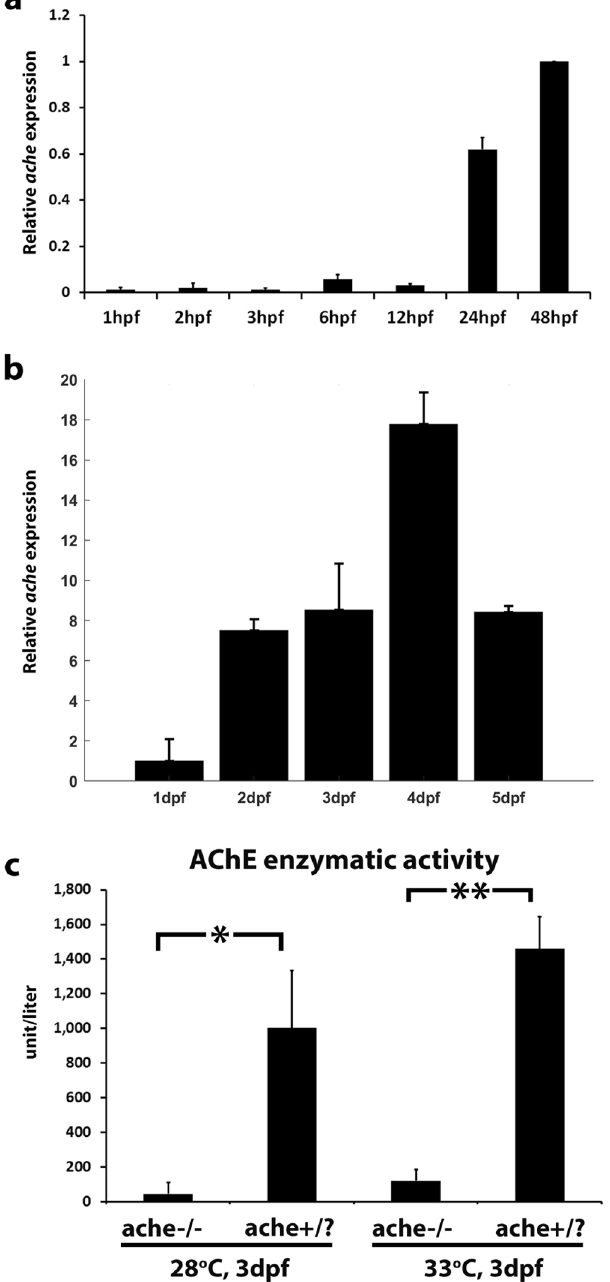
Figure 3. Temporal gene expression of zebrafish ache during embryonic and larval development. ( a ) Relative ache expression was quantified by qPCR at selected embryonic stages in AB line (N = 1 experiment, n = 20 embryos per group, standard deviation comes from technical replicates). qPCR reactions were run in duplicates and ∆∆ Ct was calculated relative to 48 hpf values and normalized with actb2 expression ( b ) Relative ache expression was quantified by qPCR at 1–5 dpf (N = 2 experiments, n = 20 embryo/larvae per group). qPCR reactions were run in duplicates and ∆∆ Ct was calculated relative to 24 hpf values and normalized with actb2 expression. ( c ) Normalized O.D. 412 values for groups of embryos. AChE enzymatic activity was almost absent in tail-test selected ache − / − mutant embryos when compared with wild-type ache + /? siblings at 28 °C ( P = 0.034) or at 33°C ( P = 0.003) (performed in triplicates, n = 8 embryos per group). Error bars show the standard